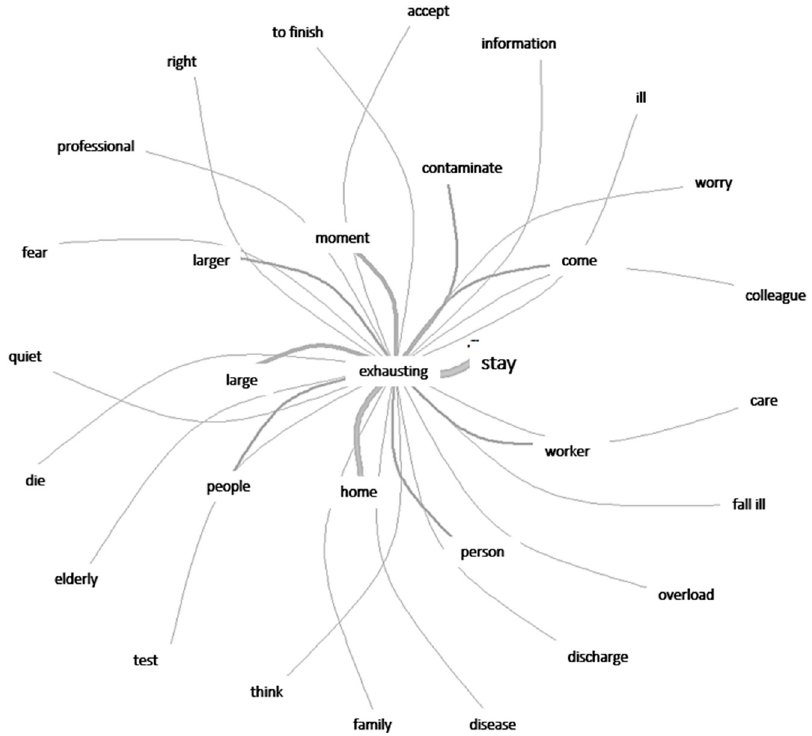
Figure 2. Graphic representation of words that express stress factors.